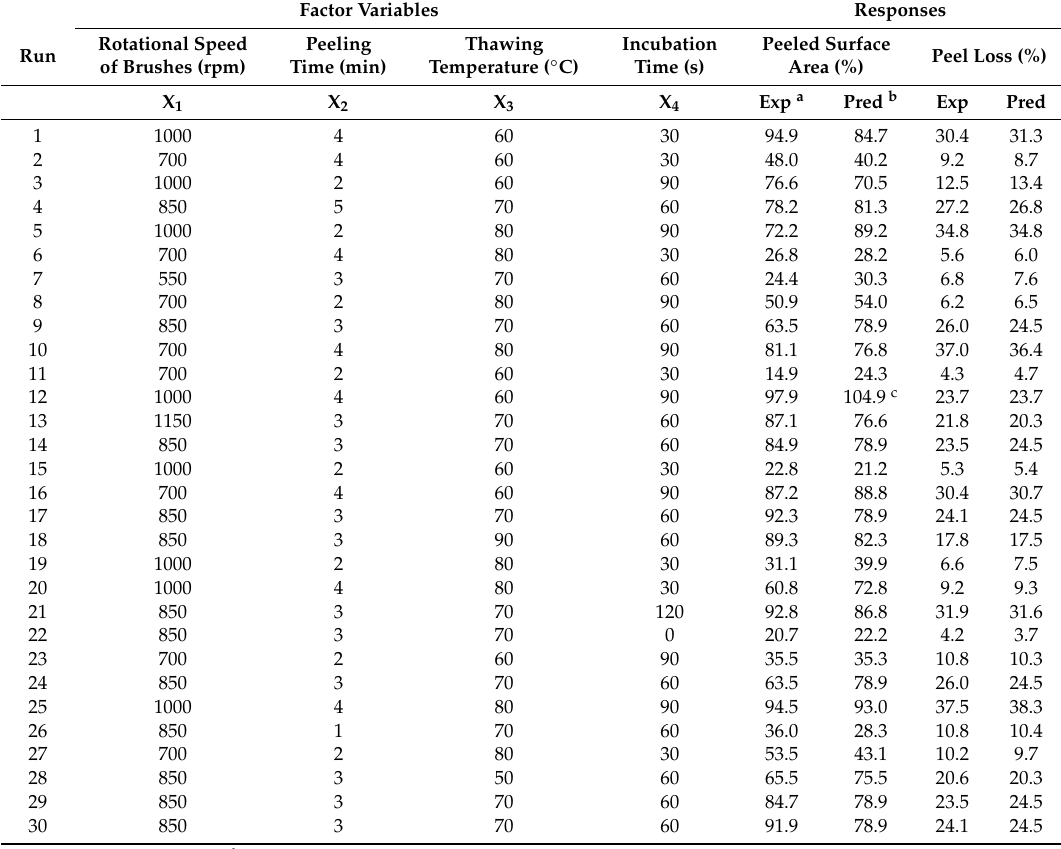
Table 3. Experimental layout designed by Design Expert and its corresponding experimental and predicted values of responses.